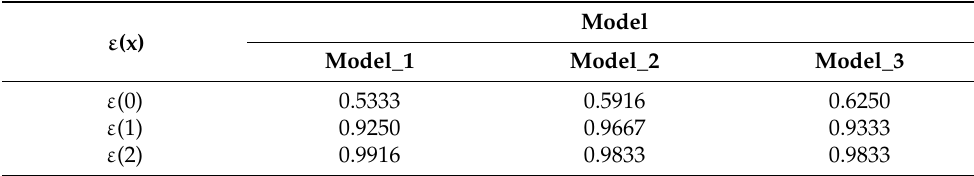
Table 1. ε (x) accuracies of the three Table 1. ε(x) accuracies of the three models.